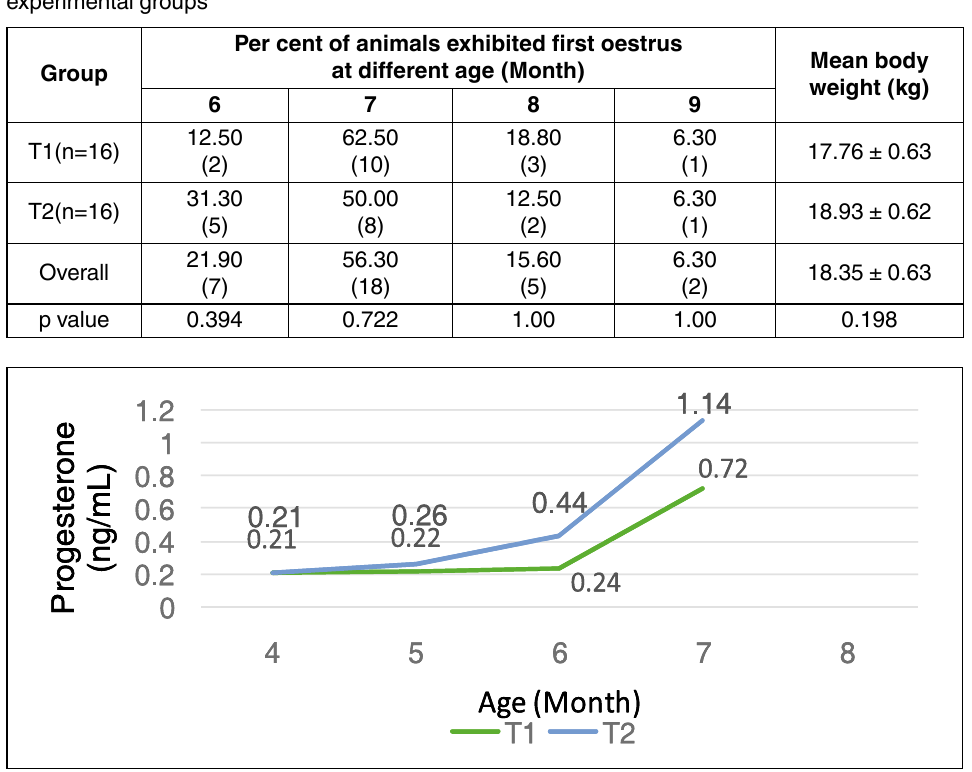
Fig. 1 Mean serum progesterone concentration (ng/mL) during post weaning period of Malabari kids fed with M. oleifera